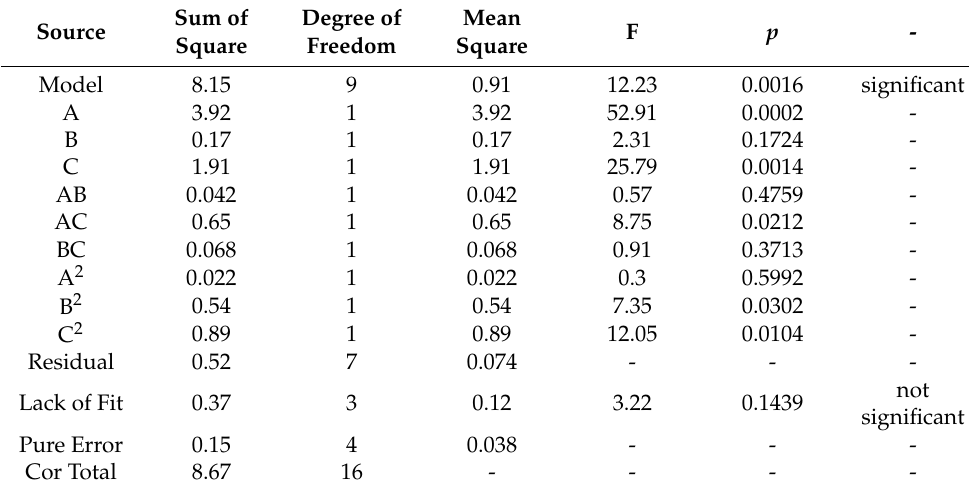
Table 7. Variance analysis of forming factor optimization